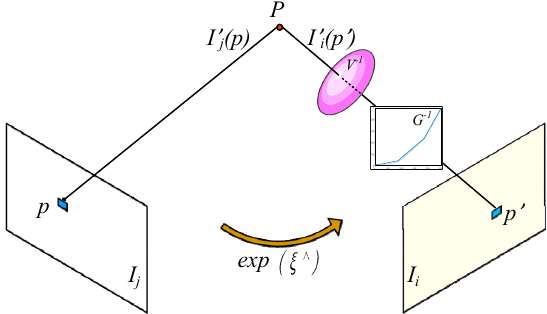
Figure 5. The photometric error based on the photometric formation. The pixel intensity of tracked point p , which is called p (cid:48) , was restored to the estimated scene radiance and then the residual with the current scene radiance was calculated to establish the photometric error equation. For the camera pose change between I j and I i , the pose equation based on the locations of p (cid:48) and p was utilized to calculate the se ( 3 ) .